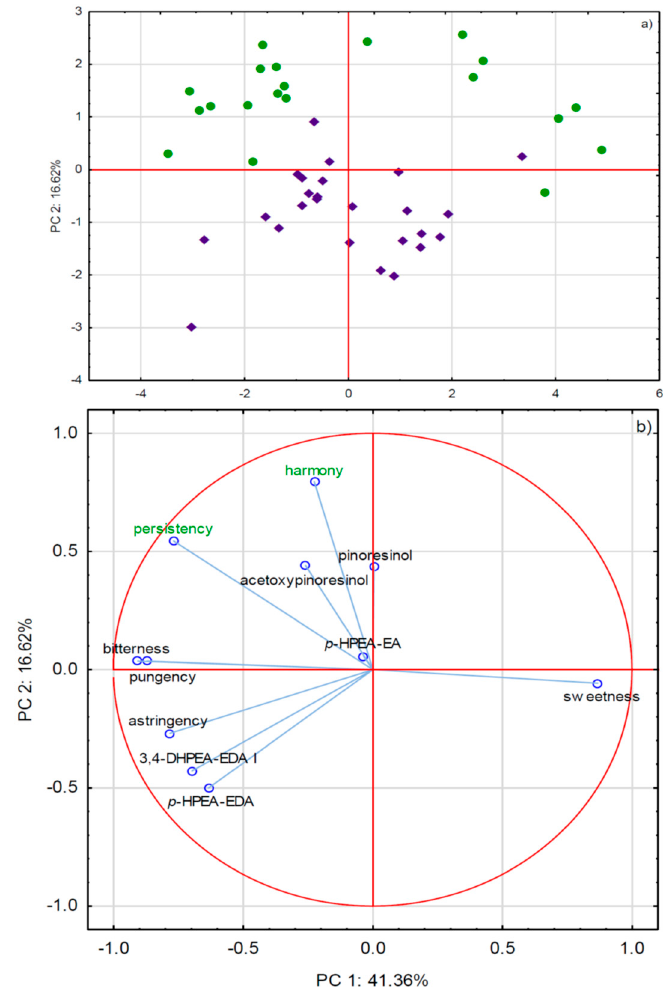
Figure 4. ( a ) Separation of olive oils sold as extra virgin olive oil (EVOO) in Italy according to the origin of purchase in two-dimensional space defined by the first two principal components, PC1 and PC2. Green cycles represent monovarietal PDO EVOO purchased on family farms, while violet rhombs represent commercial-blended EVOO purchased in supermarkets ( b ) Factor loadings of selected variables, i.e., concentrations of phenols and intensities of sensory attributes, obtained by HPLC-DAD-ESI/MS and sensory analyses, respectively, on PC1 and PC2.